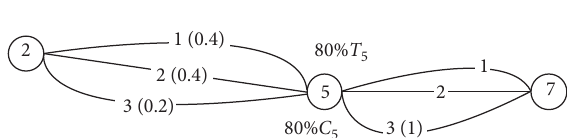
Figure 2: Schematic diagram of the distribution